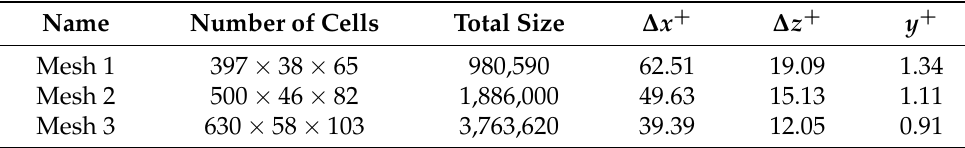
Table 1. Details of the numerical